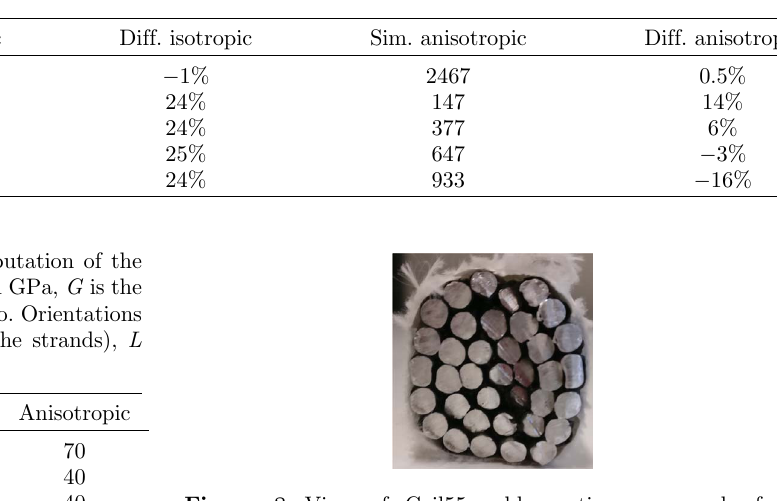
Table 2. Frequencies in Hz of Coil55 modes obtained by test (Exp.) and simulations (Sim.) with isotropic and anisotropic properties, and the relative difference (Diff.) with experiment in %.